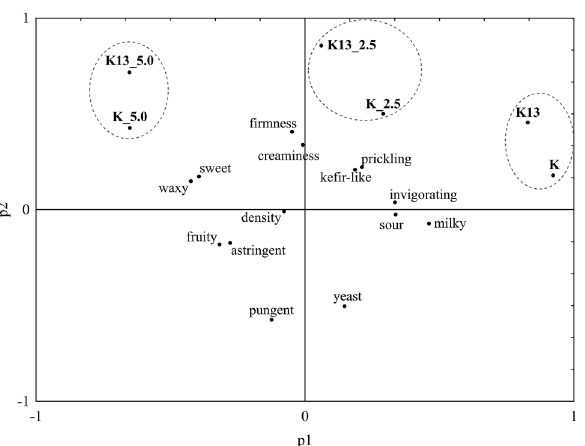
Figure 2. Principal component analysis biplot of sensory parameters used to differentiate kefir honeydew honey. K, model kefir; K13, commercial kefir; K_2.5, model kefir with 2.5% honeydew honey; K_5.0, model kefir with 5.0% honeydew honey; K13_2.5, commercial kefir with 2.5% honeydew honey; K13_5.0, commercial kefir with 5.0% honeydew